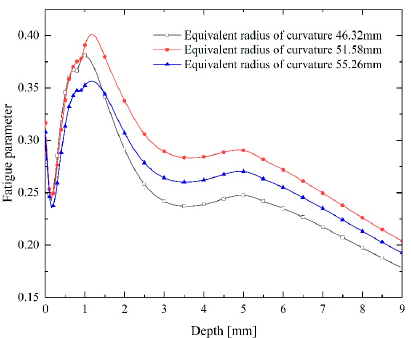
Figure 15. Effect of curvature radius on fatigue coefficient. Figure 15. E ff ect of curvature radius on fatigue coe ffi